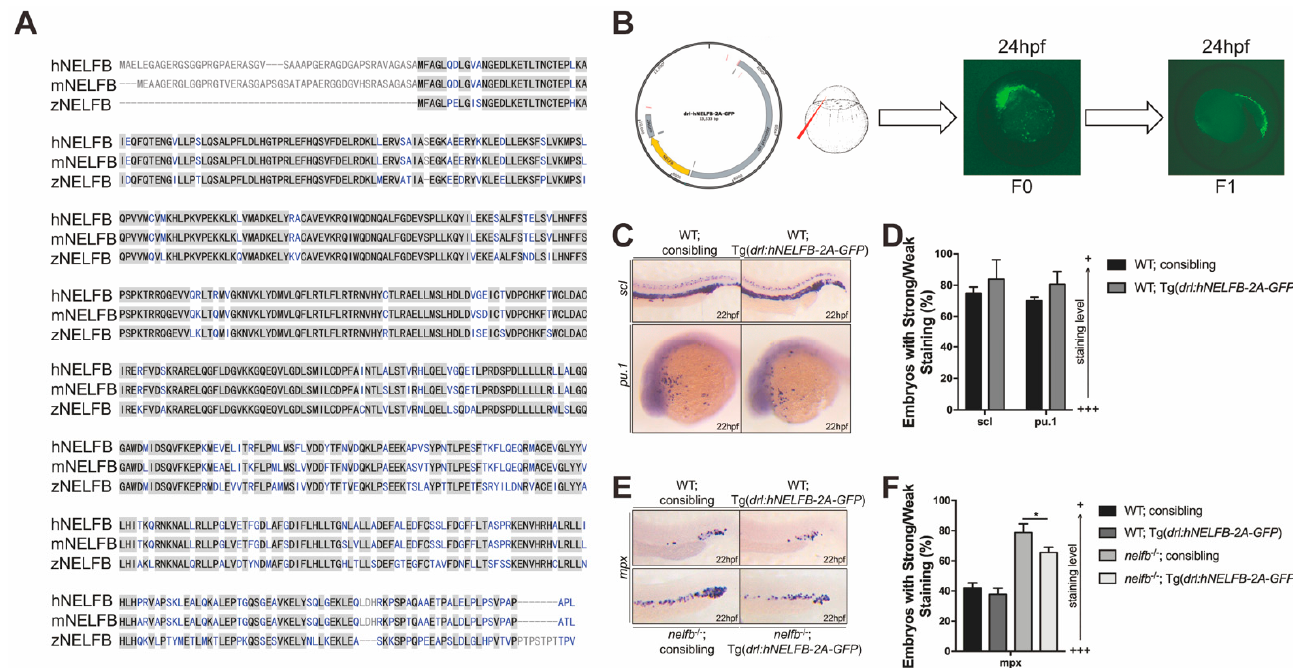
Figure 4. Expression of human NELFB in hematopoietic cells partially rescues granulopoiesis in nelfb − / − embryos. ( A ) Alignment of human, mouse, and zebrafish NELFB proteins. Identical and similar amino acids are shaded in gray. ( B ) Generation of Tg( drl:hNELFB-2A-GFP ) fish and GFP expression. ( C ) WISH for scl or pu.1 in WT and Tg( drl:hNELFB-2A-GFP ) embryos at 22 hpf. ( D ) Quantification of WISH results in ( C ) ( n = 40–60 embryos per group). ( E ) WISH for mpx in WT, Tg( drl:hNELFB-2A-GFP ), nelfb − / − and nelfb − / − ; Tg( drl:hNELFB-2A-GFP ) embryos at 22 hpf. ( F ) Quantification of WISH results in ( E ) ( n = 20–30 embryos per group). “+++” and “+” in ( D , F ) respectively represent strong staining and weak staining. All results are presented as the mean ± SD from three independent experiments ( t test, * for p < 0.05). hNELFB , human NELFB . Tg( drl:hNELFB-2A-GFP ) overexpression in WT embryos only led to a mild increase